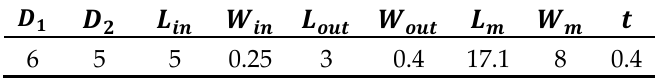
Table 1. Dimensions of the ss micro-scanner (all in mm).